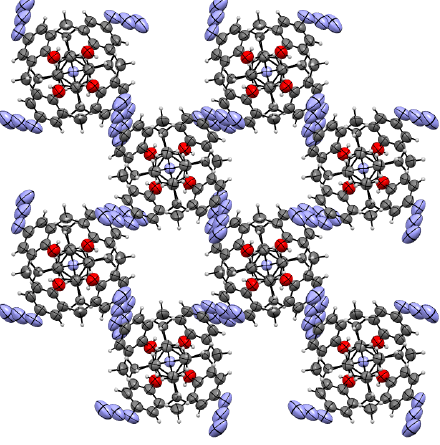
Figure 2. Crystal packing of 3 view along c